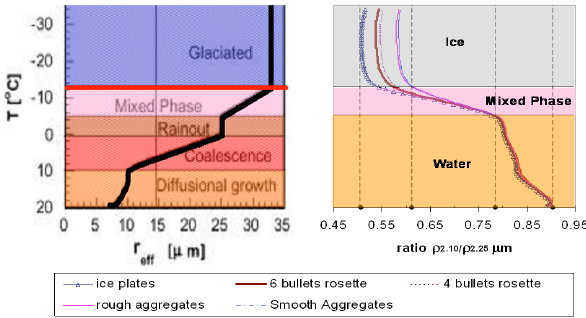
Fig. 9. (a) Adapted from Rosenfeld and Woodley (2003 – Fig. 1) shows the “general case” effective radius and thermodynamic pro- file used here for the SHDOM simulation. (b) SHDOM simulation of the reflectance ratios (2.10/2.25µm) based on a cylindrical cloud with a complex profile of particle effective radii and thermodynamic phase showing the sensitivity of this ratio to the presence of water, ice, and mixed